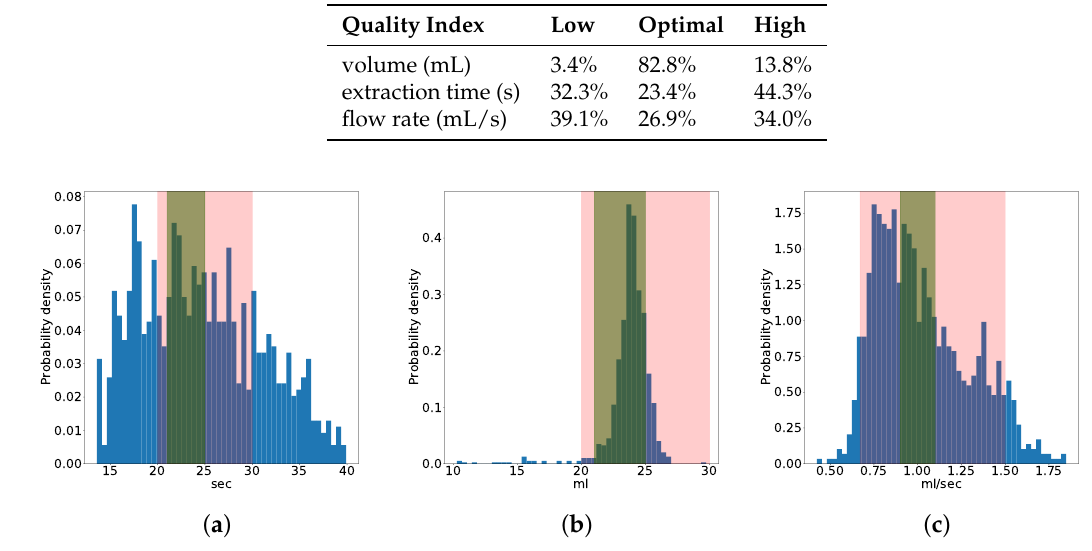
Figure 1. Distribution of values in the experimental dataset. ( a ) Percolation time, ( b ) Espresso volume, ( c ) Flow